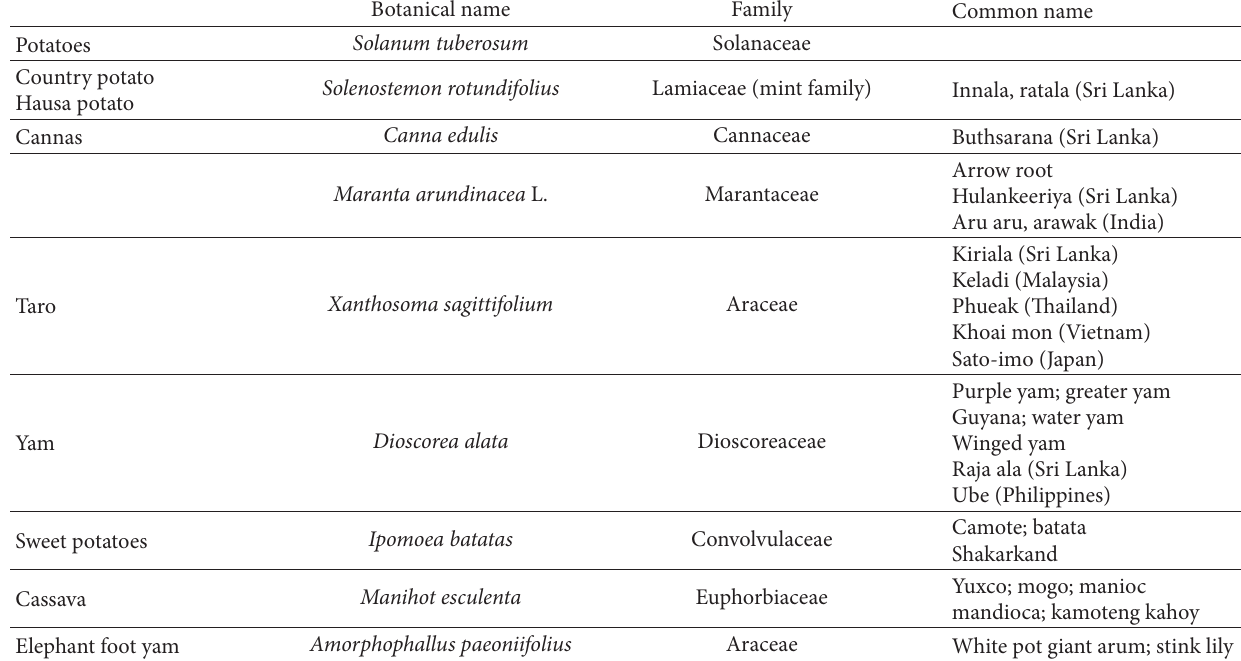
Table 2: Different types of tuber crops commonly consumed in